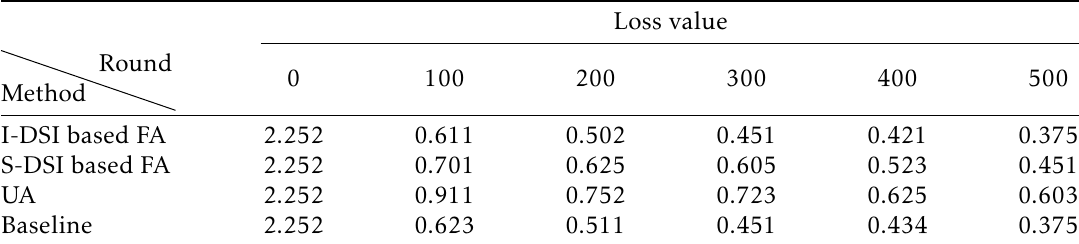
Table 2. Fault detection accuracy of various FA schemes along with FMN and delay limit β